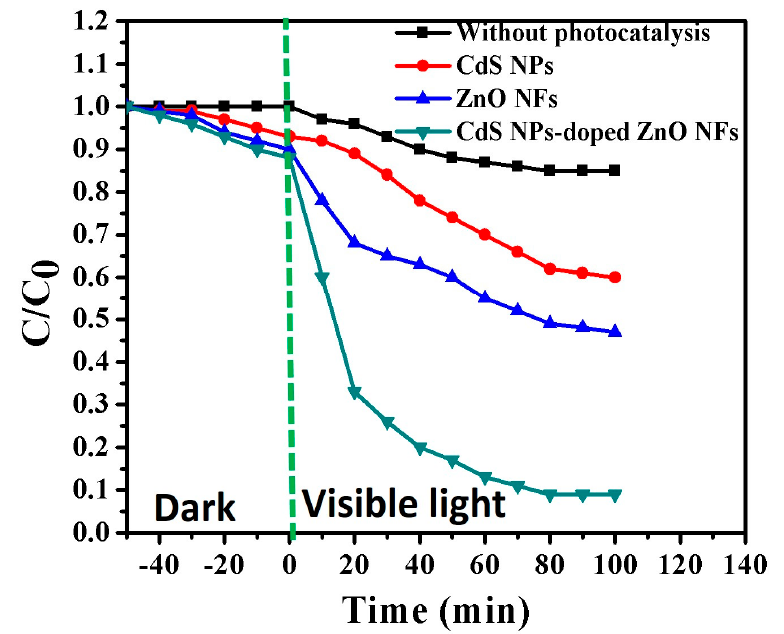
Figure 6. Comparison of the methylene blue (MB) photodegradation efficiency under visible light irradiation of the CdS NPs, ZnO NFs, and CdS NP-doped ZnO NFs. Table 2. Comparison of the values of rate constant for different photocatalysts.